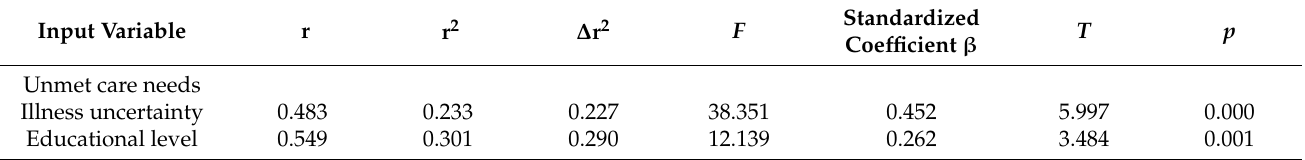
Table 7. Stepwise regression analysis of unmet care needs in breast cancer